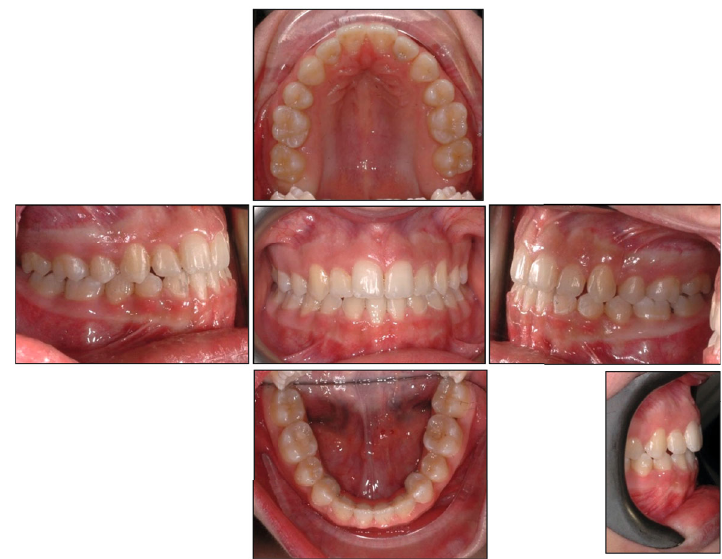
Figure 8: Final intraoral